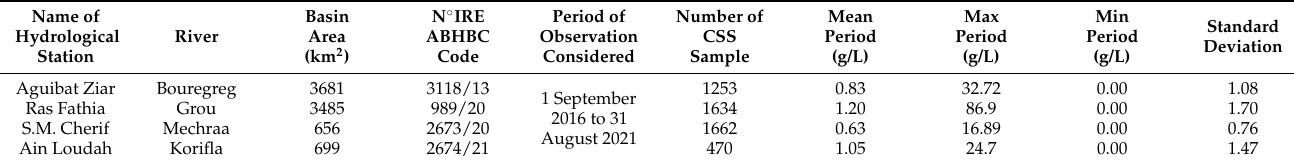
Table 1. Statistical characteristics of CSS samples at 4 hydrological stations studied.